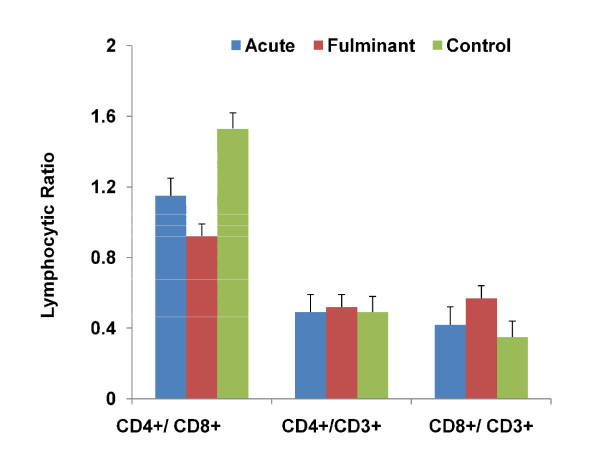
FACS analysis of T lymphocytes showing lymphocytic ratio (CD4+/CD8+) of acute (AVH), fulminant (FHF) and normal healthy control (C). Mann-Whitney U-test was applied to find the statistical difference between the above groups. CD4+/CD8+; AVH vs FHF: P = 0.038, AVH vs C: P = 0.063, FHF vs C: P = 0.000 CD4+/CD3+; AVH vs FHF: P = 0.366, AVH vs C: P = .029; FHF vs C: P = 0.818 CD8+/CD3+; AVH vs FHF: P = 0.112, AVH vs C: P = 0.08, FHF vs C: P = 0.018.